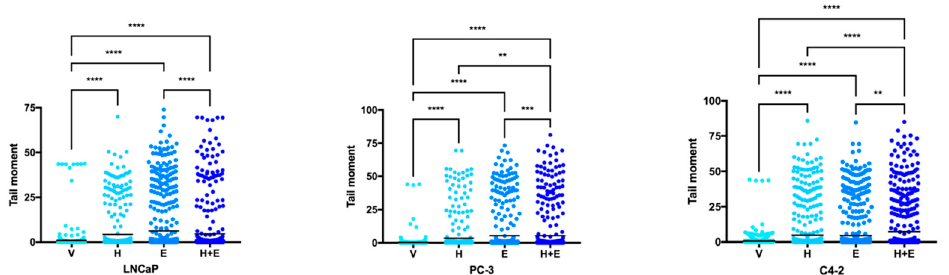
Figure 6. The combined treatment of hydralazine and enzalutamide augmented DNA damage (here represented by the tail moment measurement) in PCa (prostate cancer) cells. The presented data are representative of at least 500 cells analysed. The mean ± standard deviation were as follows: LNCaP V—0.96 ± 5.33; LNCaP H—4.23 ± 10.8; LNCaP E—6.19 ± 13.9; LNCaP H+E—4.53 ± 12.9; PC-3 V—